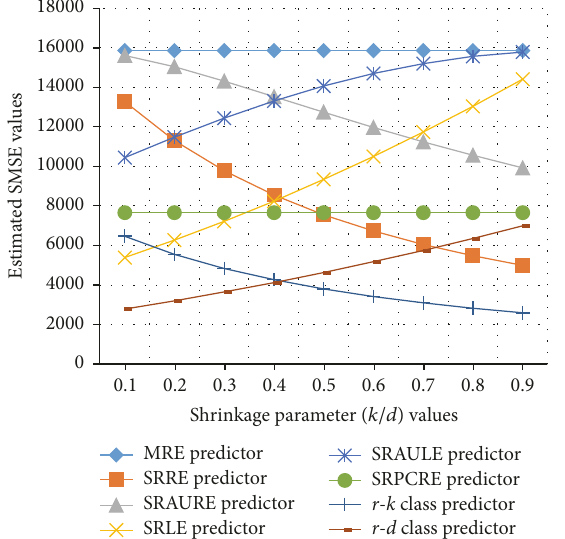
Figure 5: SMSE values of the predictors in the misspecified regression model when 𝑛 = 50 and 𝜌 = 0.99 .